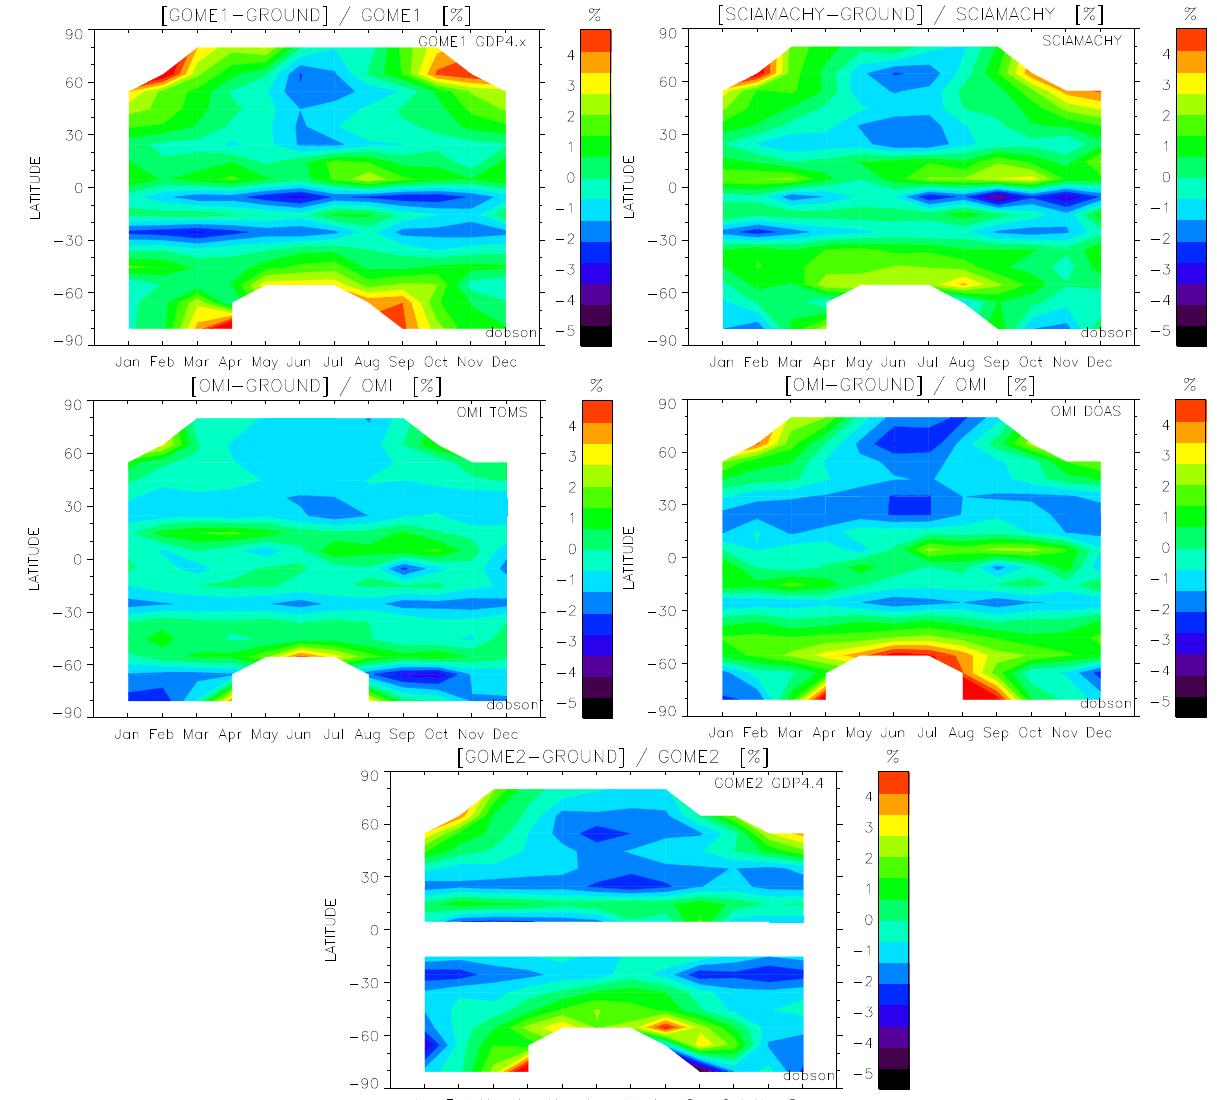
Fig. 3. Contour representation of the percentage differences between satellite and Dobson ground-based total ozone measurements depicted as a function of solar zenith angle and season. Top left: GOME. Top right: SCIAMACHY. Middle left: OMI TOMS. Middle right: OMI DOAS. Bottom: